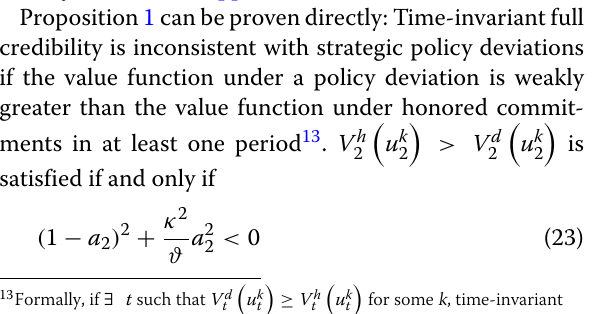
Fig. 2 The optimal impact coefficient in the policy rule. The inflation rate, the output gap, and the cost-push shock under two policy simulations. Simulation a (dashed lines) assumes central bank credibilities (cid:16) (cid:15) T + 1 = { 1,1,0,0 } . In both simulations, the sequence of cost-push shocks is { u γ b t t = 0 impact coefficient of the cost-push shock on the output gap in the policy rule, the persistence parameters j = { a , b